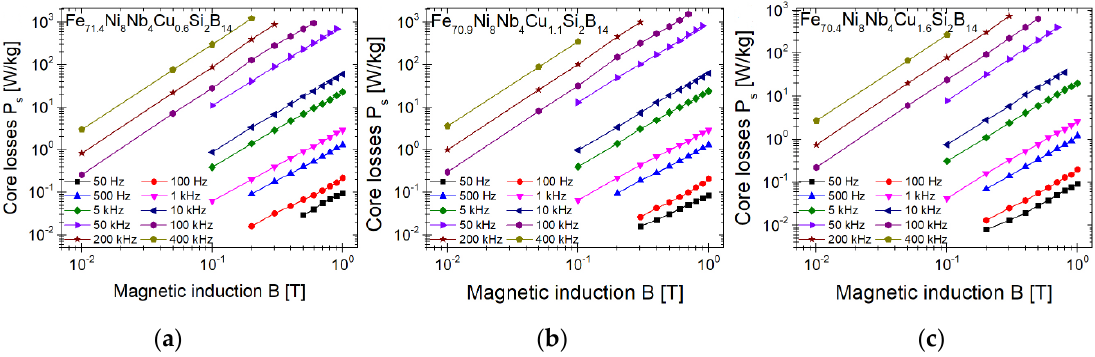
Figure 5. Core power losses Ps of annealed at 460 °C metallic ribbons: Fe 71.4 Ni 8 Nb 4 Cu 0.6 Si 2 B 14 ( a ), Fe 70.9 Ni 8 Nb 4 Cu 1.1 Si 2 B 14 ( b ) and Fe 70.4 Ni 8 Nb 4 Cu 1.6 Si 2 B 14 ( c ) measured at 50 Hz–400 kHz in function of magnetic induction. Table 2. Different core power losses values of Fe 72 − x Ni 8 Nb 4 Cu x Si 2 B 14 alloys ( x = 0, 0.6, 1.1, 1.6). Ps [W/kg] x = 0.6 Ps